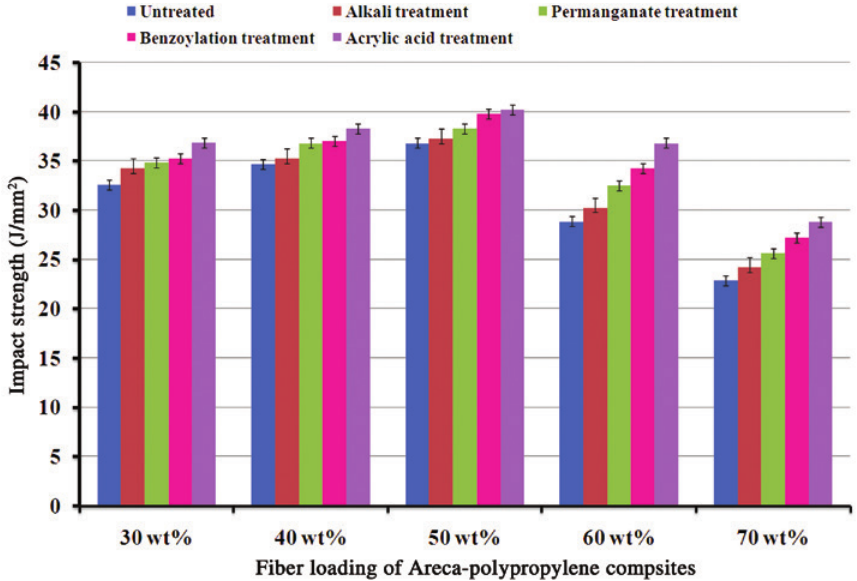
Figure 5: Impact strength of areca-polypropylene composites with different loadings.